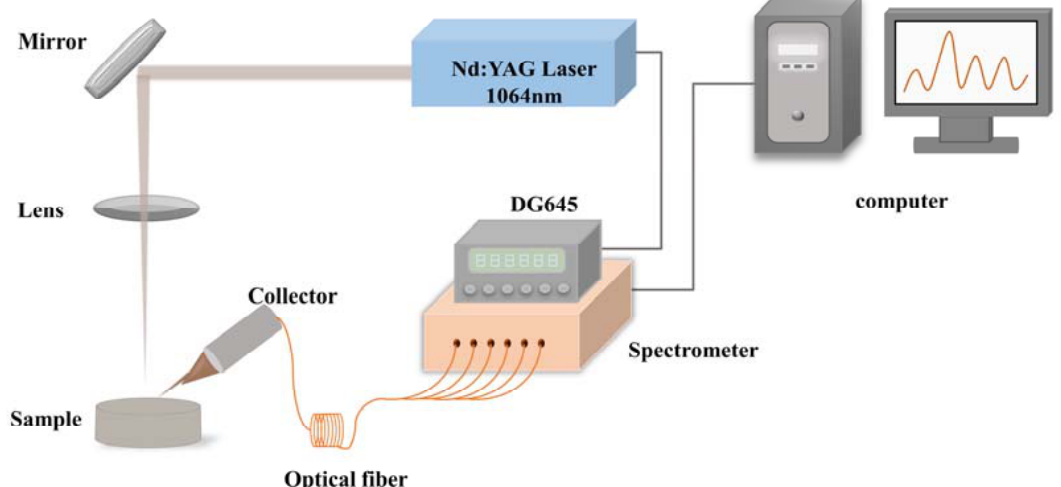
Figure 1. The schematic diagram of LIBS experimental setup.